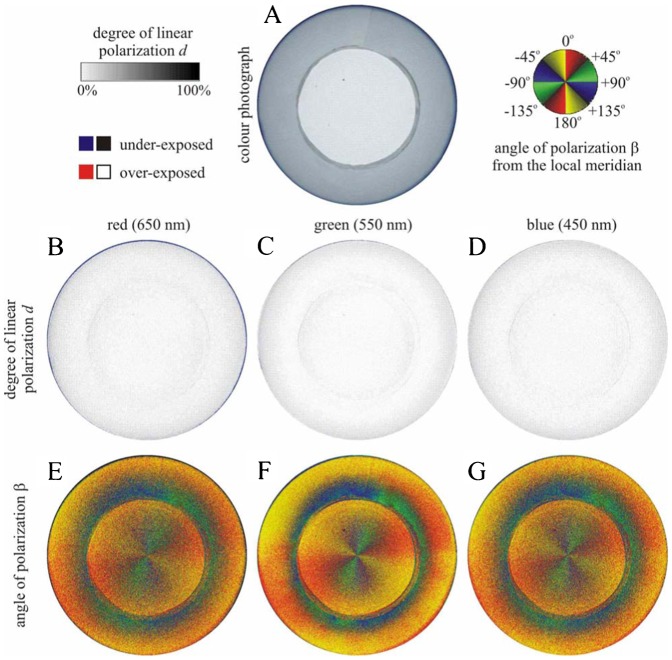
As Fig. 12 when the Emlen funnel was covered by a 2 mm thick depolarizing milky plastic board